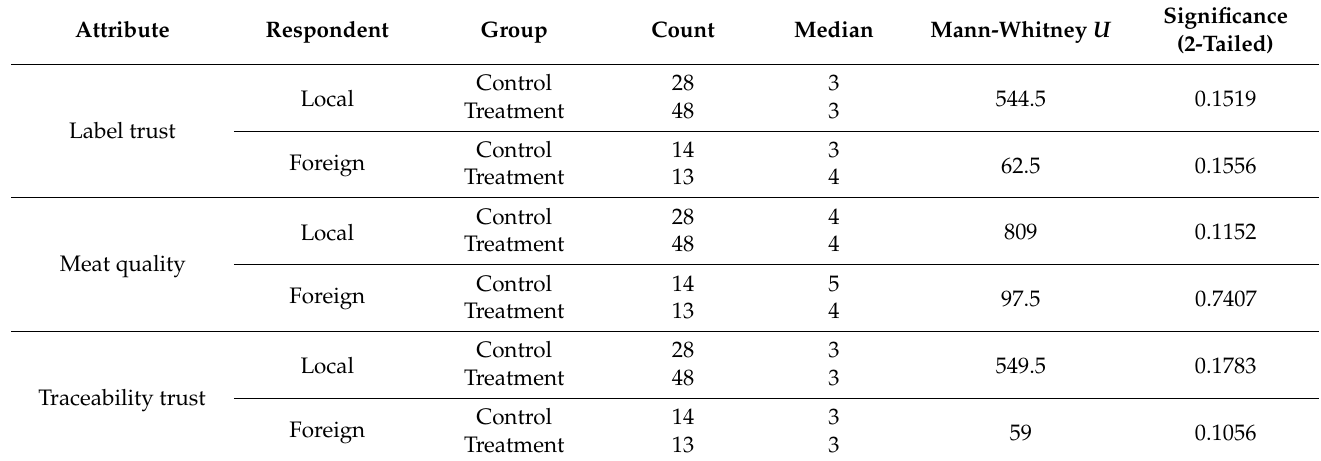
Table 3. Mann–Whitney U test for respondent perceptions between control and treatment groups.